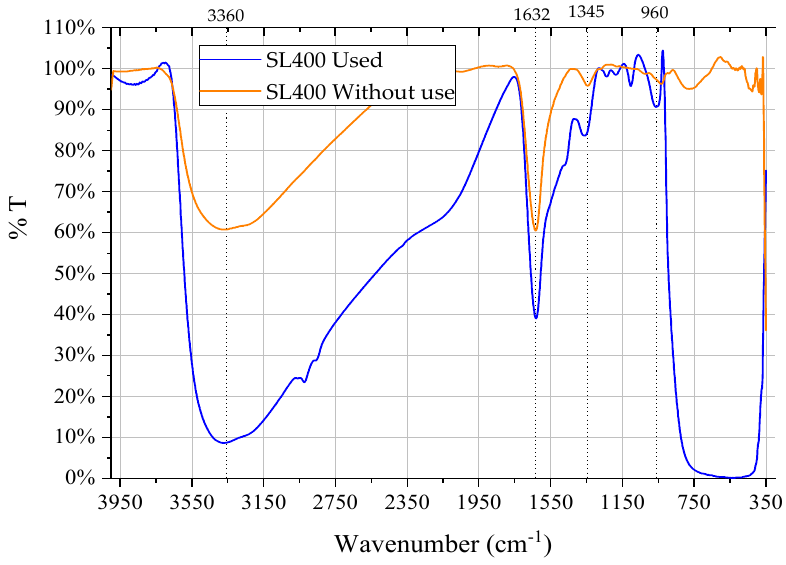
Figure 8. FTIR spectra of SL400 before and after the photocatalytic reaction.